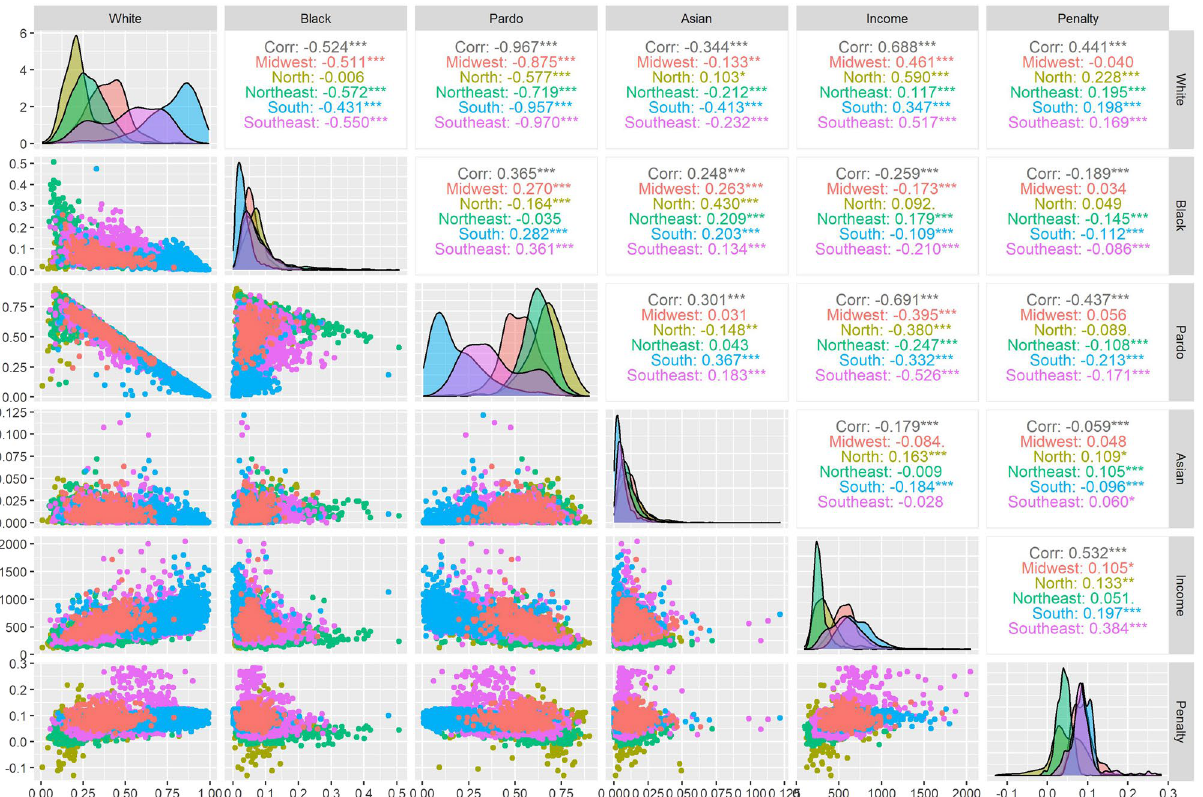
Figure 2. Correlation matrix, density plots, and scatter plots for weather penalty, population by race groups, and income stratified by regions. Note : *indicates the significance level for the Spearman coefficients; “Corr” is the correlation at national level.